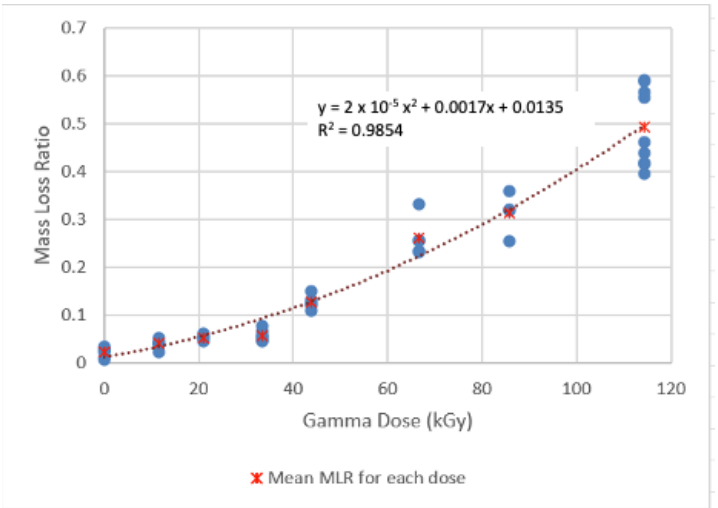
Figure 24. MLR of the PLA resin irradiated over 0 – 11 kGy gamma dose (Hot Press Conditions: 227°C, 16 min hold time). Table 7. Statistical analysis of the MLR of the PLA resins irradiated with a 0 – 11 kGy gamma dose.